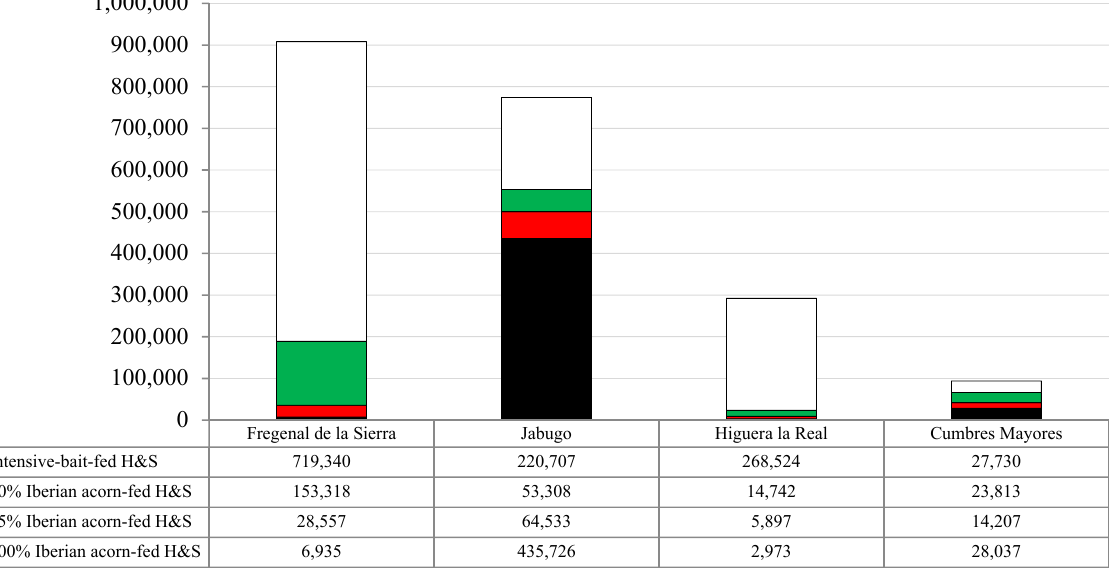
Figure 9. Hams and shoulders market in the four LPS-IPTIs in 2019. Source: [82]. Authors own elaboration.